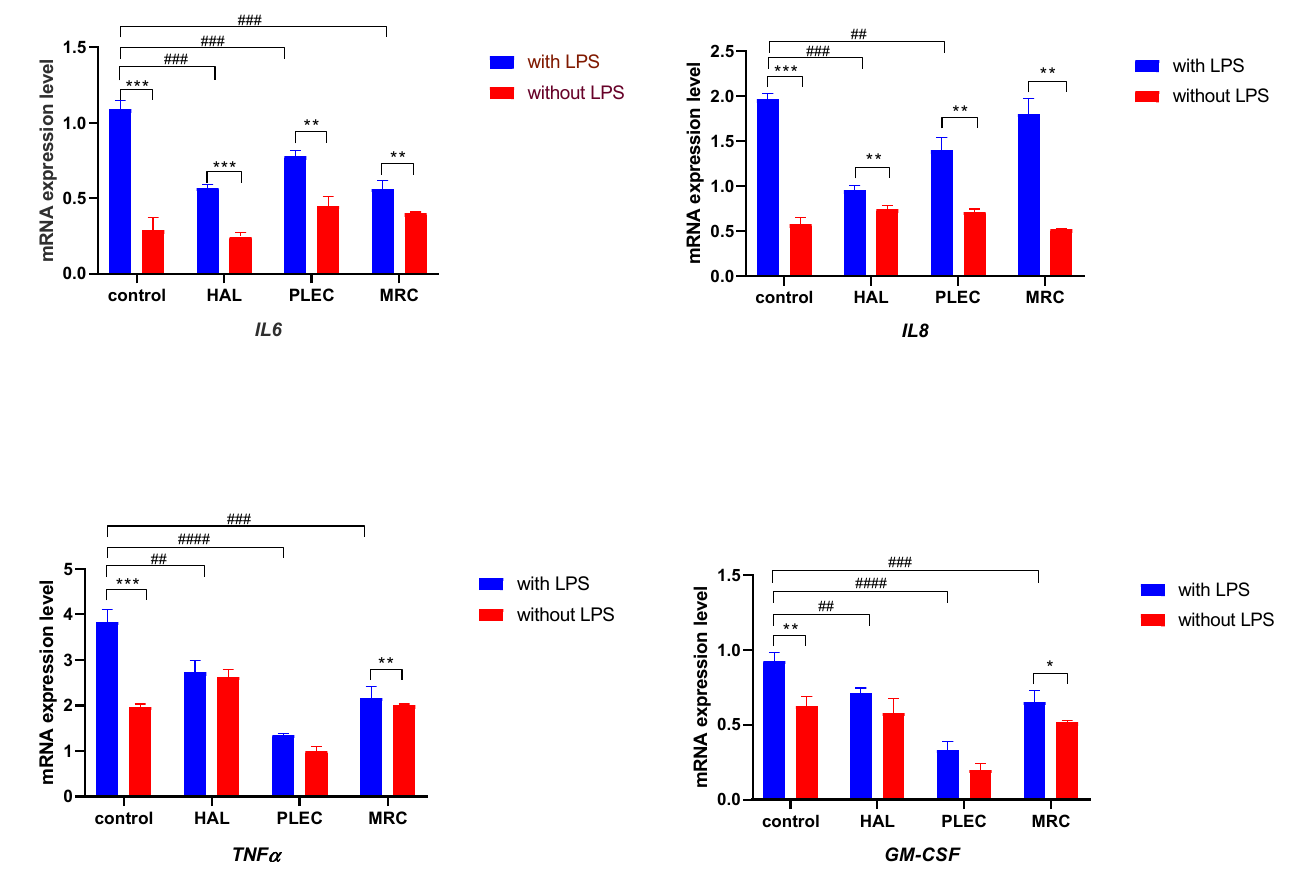
Figure 8. Gene expression ( IL6 , IL8 , TNF α and GM-CSF ) for ARPE-19 cell lines after one-hour pre-treatment of LPS and 24 h treatment with compounds (HAL, PLEC and MRC). The 18S RNA was used as a reference gene. The relative expression of mRNA was calculated by the 2- Δ Ct method (where Δ Ct is the value obtained by subtracting Ct of 18S rRNA mRNA from Ct of IL6 , IL8 , TNF α and GM-CSF mRNAs, respectively). Data are shown as means ± SD. Statistical differences between groups (treated LPS vs. untreated) at * p < 0.05, ** p < 0.01 and *** p < 0.001 are indicated by stars above the bars. ## p < 0.01, ### p < 0.001 and #### p < 0.0001 cells treated with LPS followed by the appropriate compound relative to control cells (only LPS treated).